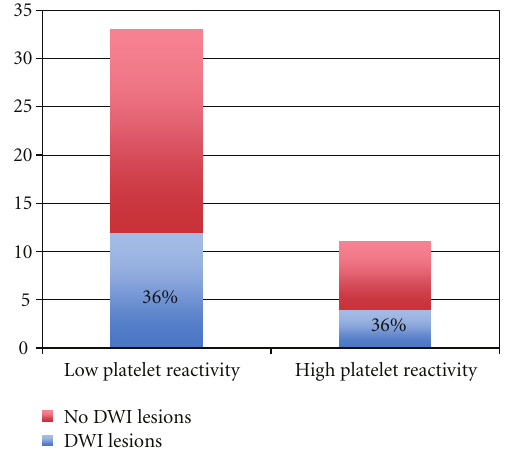
Figure 2: Shows the number of patients with (blue) and without (red) DWI lesions among responders and non-responders.